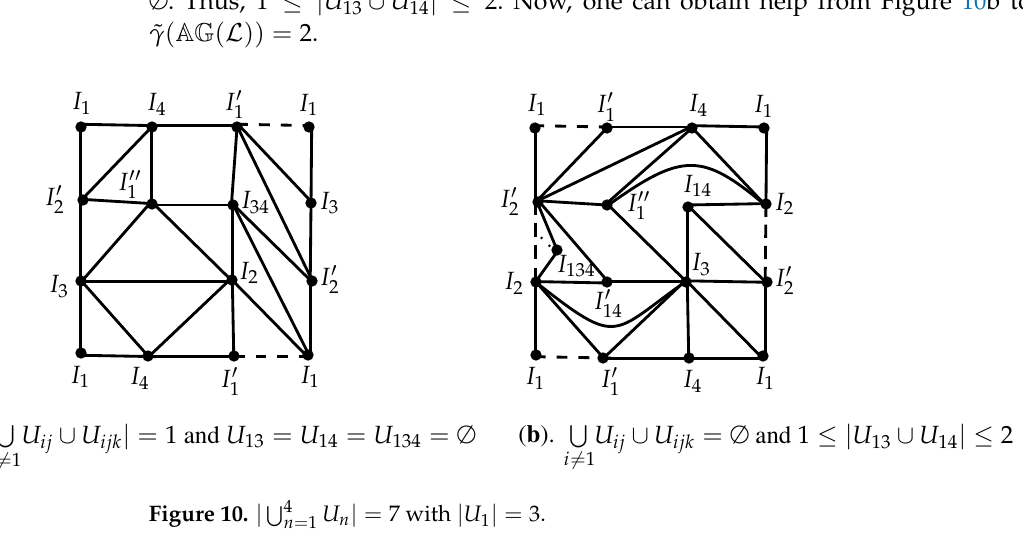
∪ ∪ 4 4 U n | = 7 with | U 1 | = 3 Figure 10. | U n | = 7 with | U 1 | = n = 1 n = 1